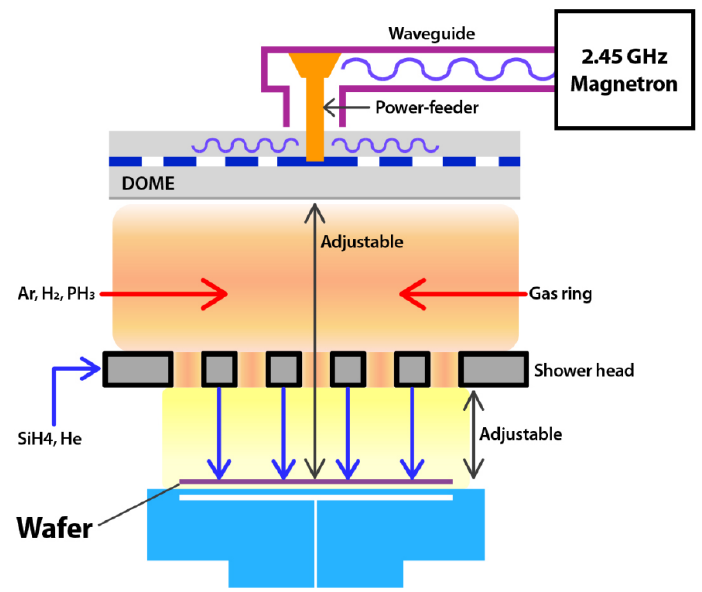
Figure 1. Schematic of the microwave plasma reactor.